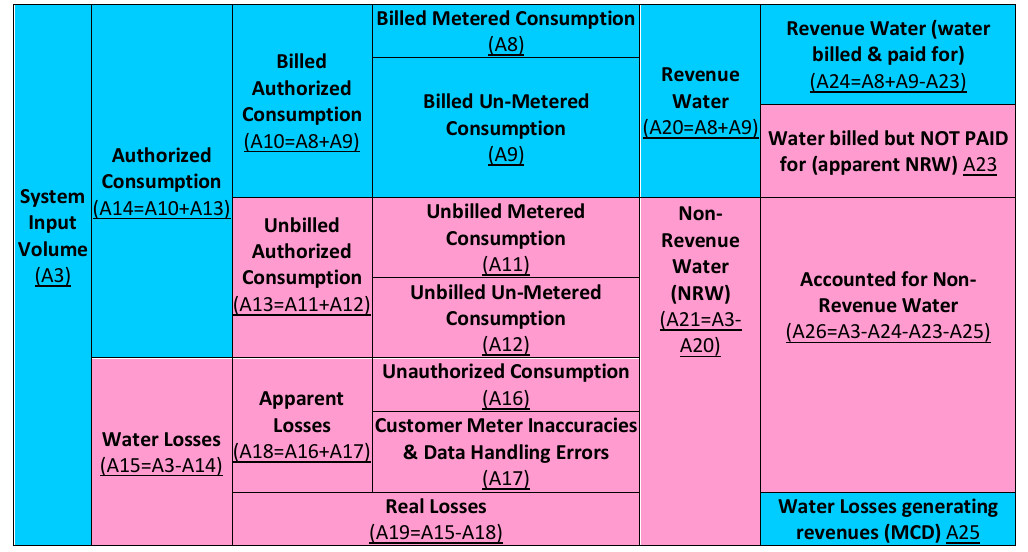
Figure 2. Second modified WB